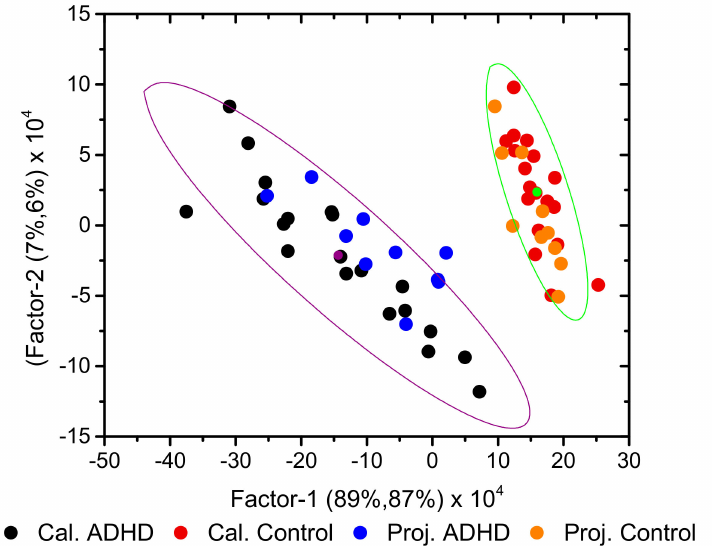
Figure 6. 2D scores plot (Factor-2 vs. Factor-1) of the developed PLS-DA model, showing the calibration (Cal.) and projected test set (Proj.) samples. The 95% confidence ellipses for the calibration set are shown. The points with the same color of the ellipses correspond to their centers and are the average point of the associated